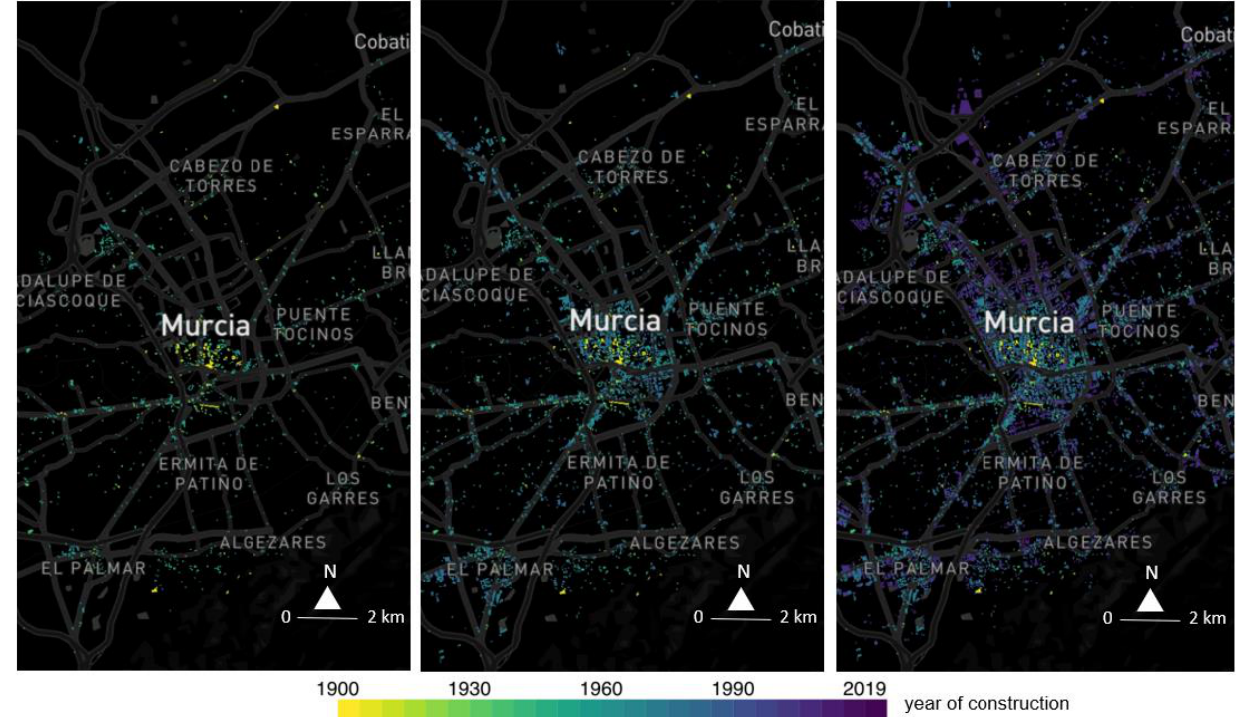
Figure 5. Spatial representation at a metropolitan scale of the evolution of urban growth in the metropolitan area of the city of Murcia in 1940 ( left ), 1980 ( center ) and 2019 ( right ). Data source: General Directorate of the Cadaster of Spain. Table 3. Numerical evolution of GIS indicators of urban growth in Murcia from 1950 to